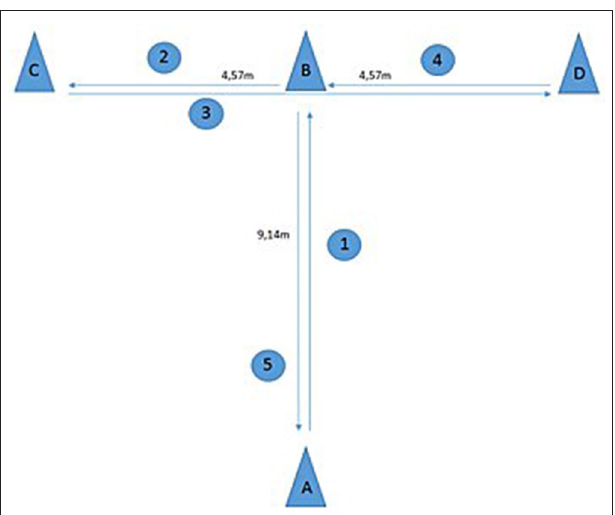
FIGURE 2 | The T -Test is a useful agility test for the assessment of multidirectional movement (forward, lateral, and backward). The cones are set up as depicted in the figure. The goal is to complete the course as quickly as possible (A-B-C-D-B-A). The player shuffles through the course between the cones and must physically touch each cone with the correct hand. The fastest time is